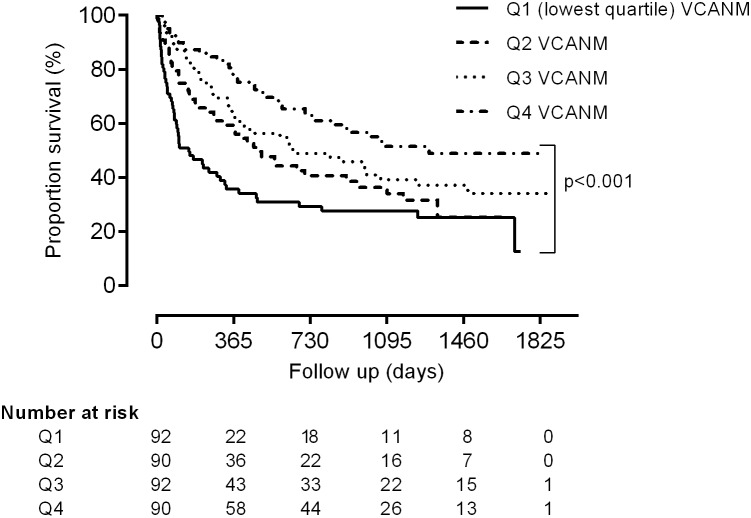
Kaplan-Meier survival curves for haemodialysis patients stratified in quartiles according to plasma VCANM levels.